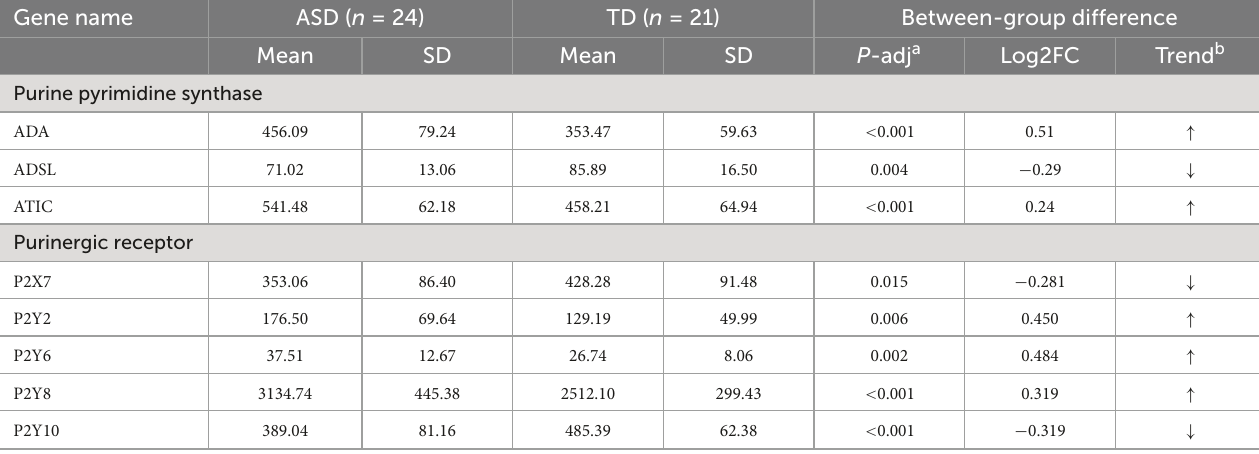
TABLE 3 Significant differentially expressed genes and their trends were obtained by comparing the normalized counts of gene expression in the ASD and TD groups.